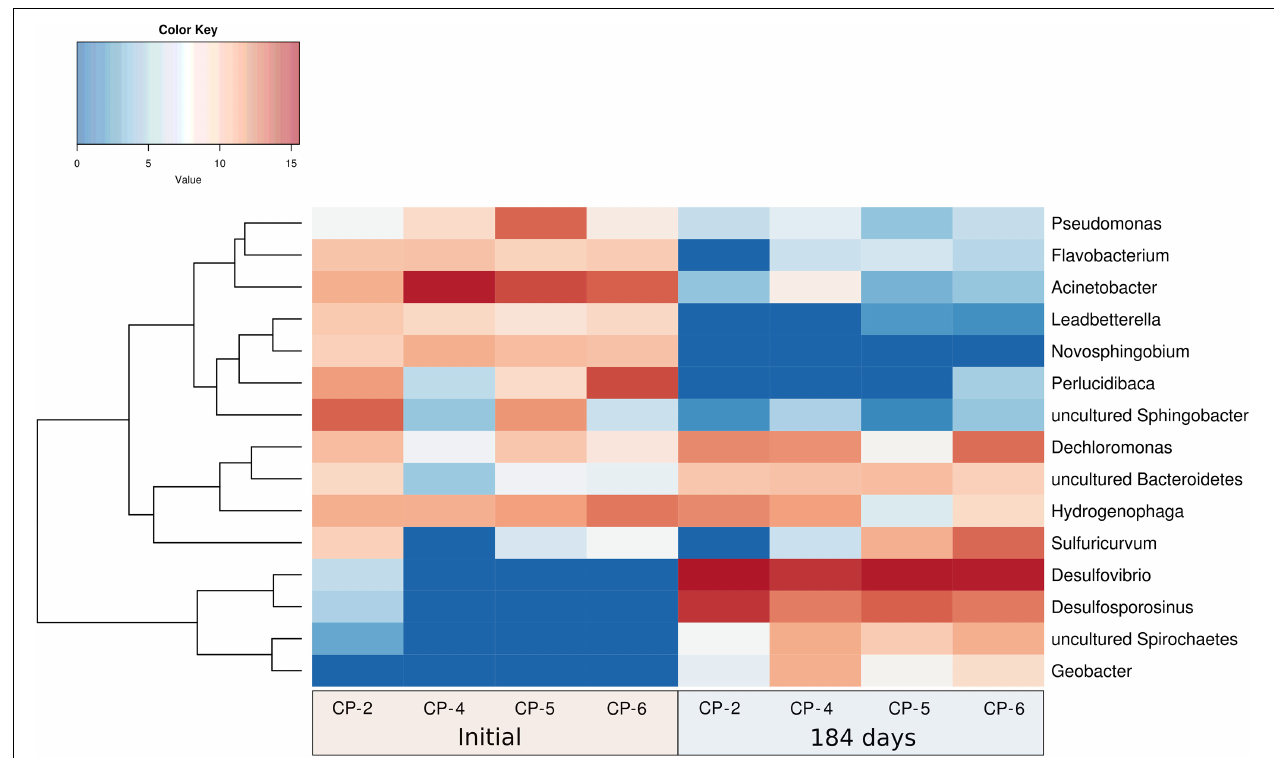
FIGURE 11 | Hierarchical cluster analysis ( Y -axis), and heatmap showing the relative abundances of the most abundant genera identified in the Nitrastur groundwater samples from wells CP-2, CP-4, CP-5 and CP-6, before (0) and at the end of the experiment (184 days).